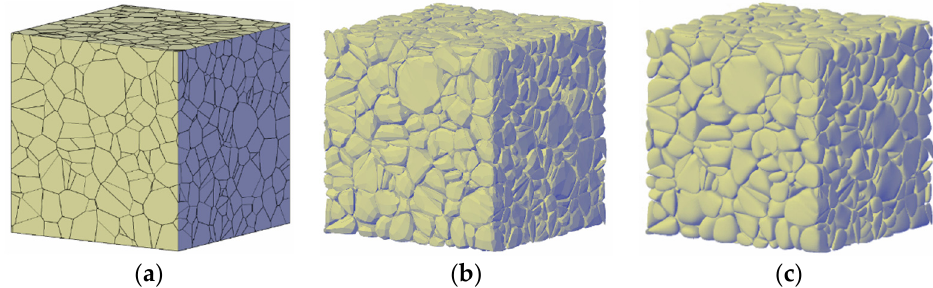
Figure 2. Initial Laguerre tessellation and polyhedrons after geometric smoothing in a cubic sample. ( a ) Initial Laguerre tessellation (smoothness level = 0), ( b )smoothness level = 1, and ( c ) smoothness level = 3.